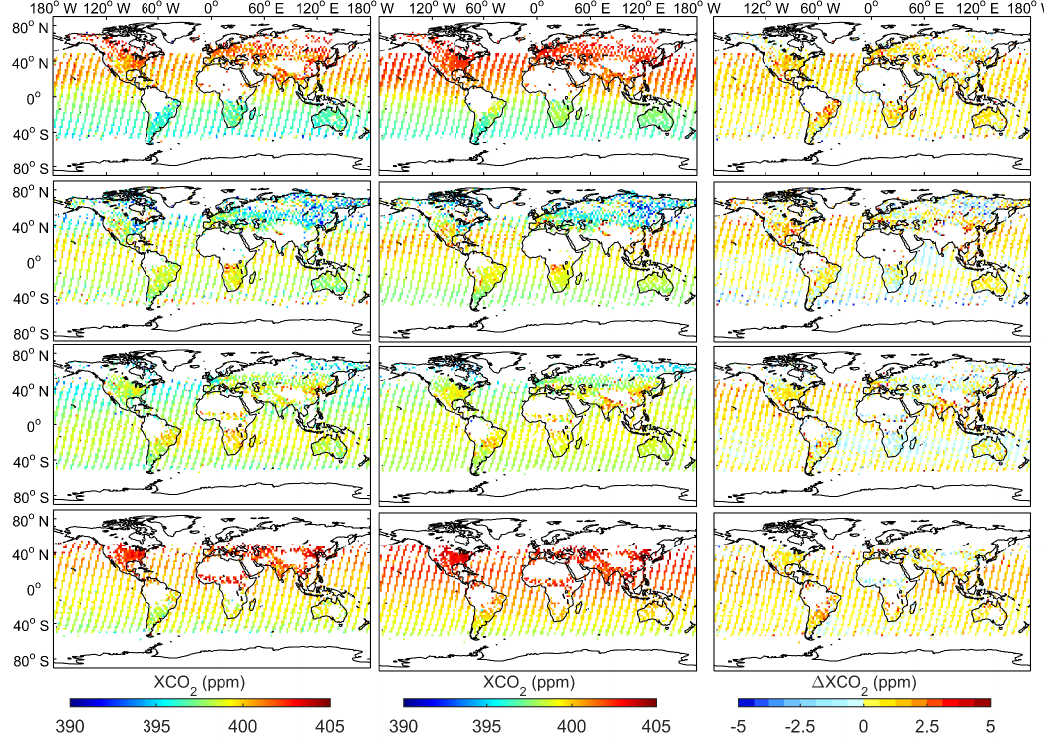
Figure 12. Global distributions of the GOSAT XCO 2 (left panel), CT2017-modeled XCO 2 (middle panel) and the differences between the CT2017 XCO 2 and GOSAT XCO 2 (right panel; ∆ XCO 2 =XCO 2 _CT − XCO 2 _GOSAT). Each row of panels, from top to bottom, subsequently represents spring, summer, autumn and